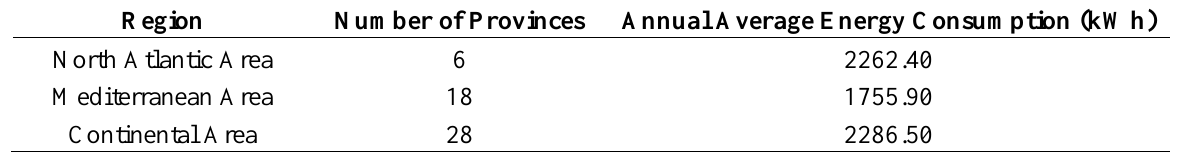
Table 2. Annual average domestic hot water (DHW) energy consumption per house in different regions from Spain